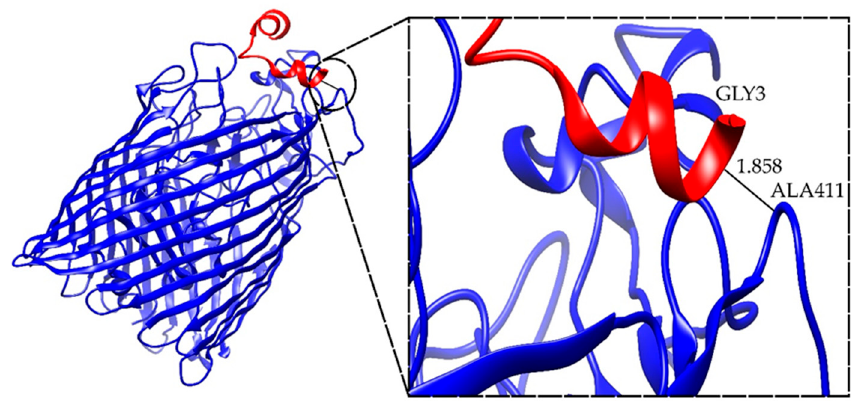
Figure 4. Structure of FhuA + M6_A_1 complex. The images of the remaining selected complexes can be found in the supplementary information.